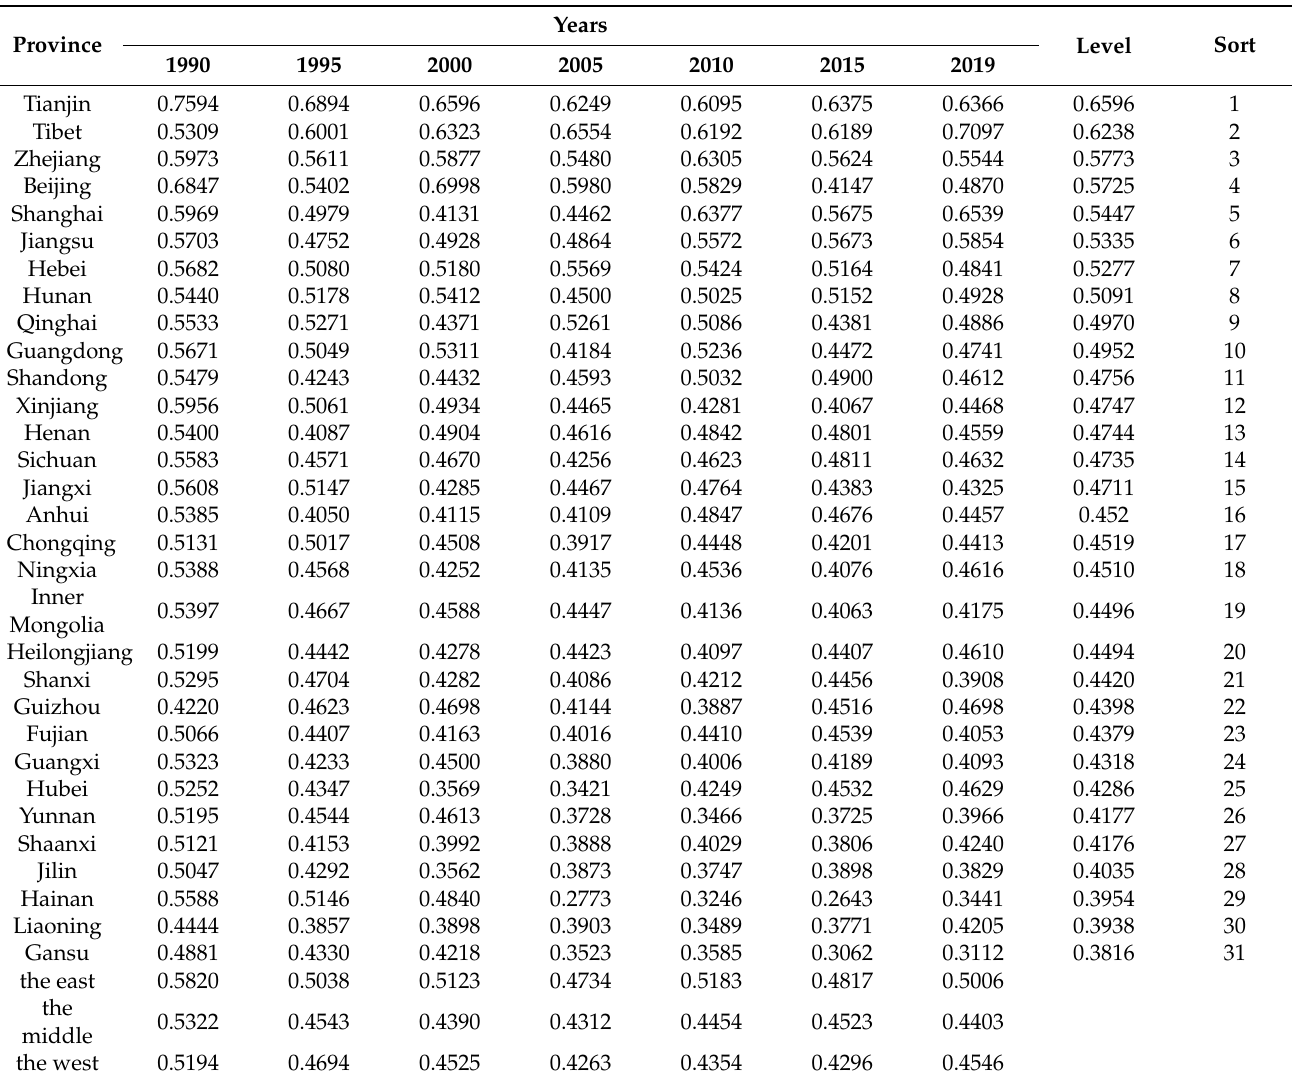
Table 4. China Agricultural Green Development Index.